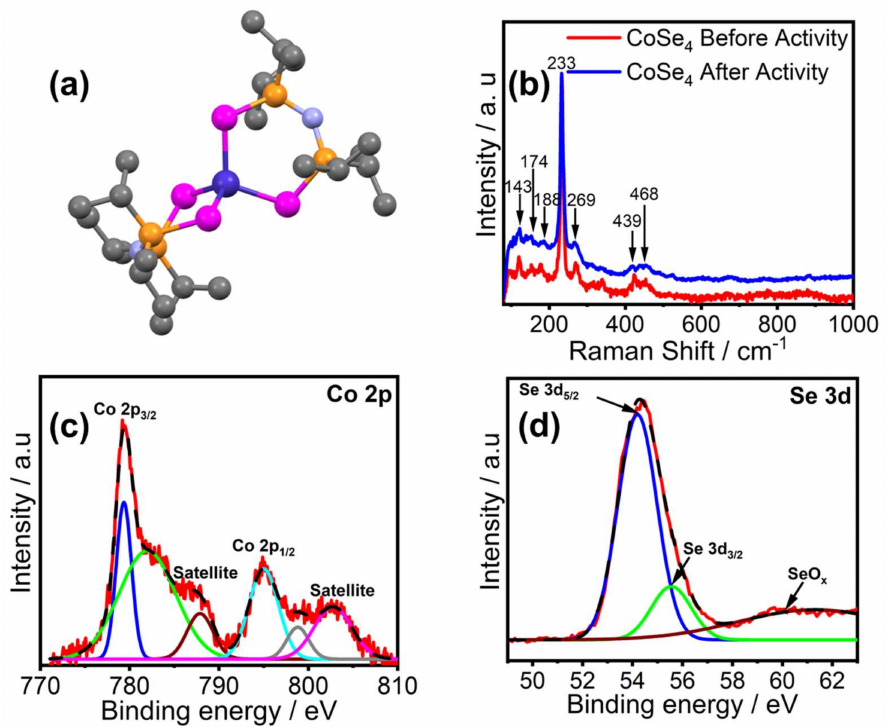
Figure 1. ( a ) The molecular structure of the [Co{(SeP i Pr 2 ) 2 N} 2 ] complex ( CoSe 4 catalyst), showing the tetrahedral cobalt–seleno-coordination. Color coding: Co (dark blue), Se (magenta), P (brown), N (light blue), C (gray). ( b ) Raman spectra of the complex measured before and after OER catalytic activity. ( c ) Co 2p XPS peaks. ( d ) Se 3d XPS peaks.